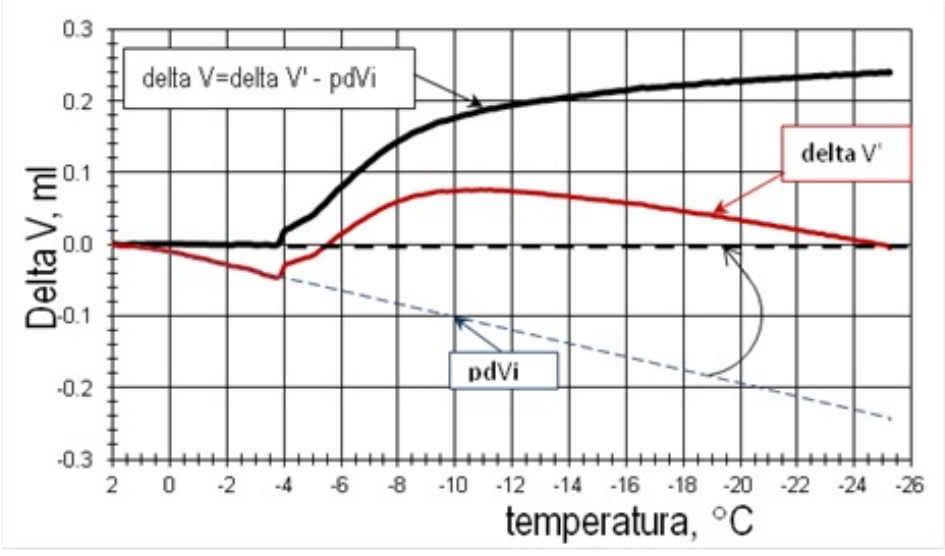
Figure 4. The method of determining pdV i correction and calculating the deformation Δ V [10]. An EO value of 100% means that all water in the pores of the material was frozen.